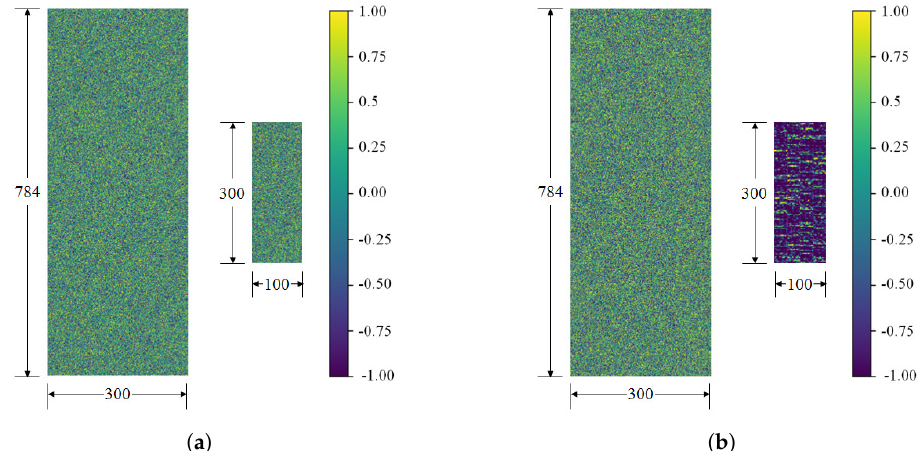
Figure 9. The weight map ( a ) before and ( b ) after training using the proposed method with five levels. These maps are made using the result of LiCoO 2 . ( a , b ) are composed of three sub-figures. The first and second are weight maps of 784 × 300 and 300 × 100, respectively. Since two weight maps with different dimensions are expressed at the same height, the size of the pixels representing a weight in the two sub-figures are different. The third is information of weight